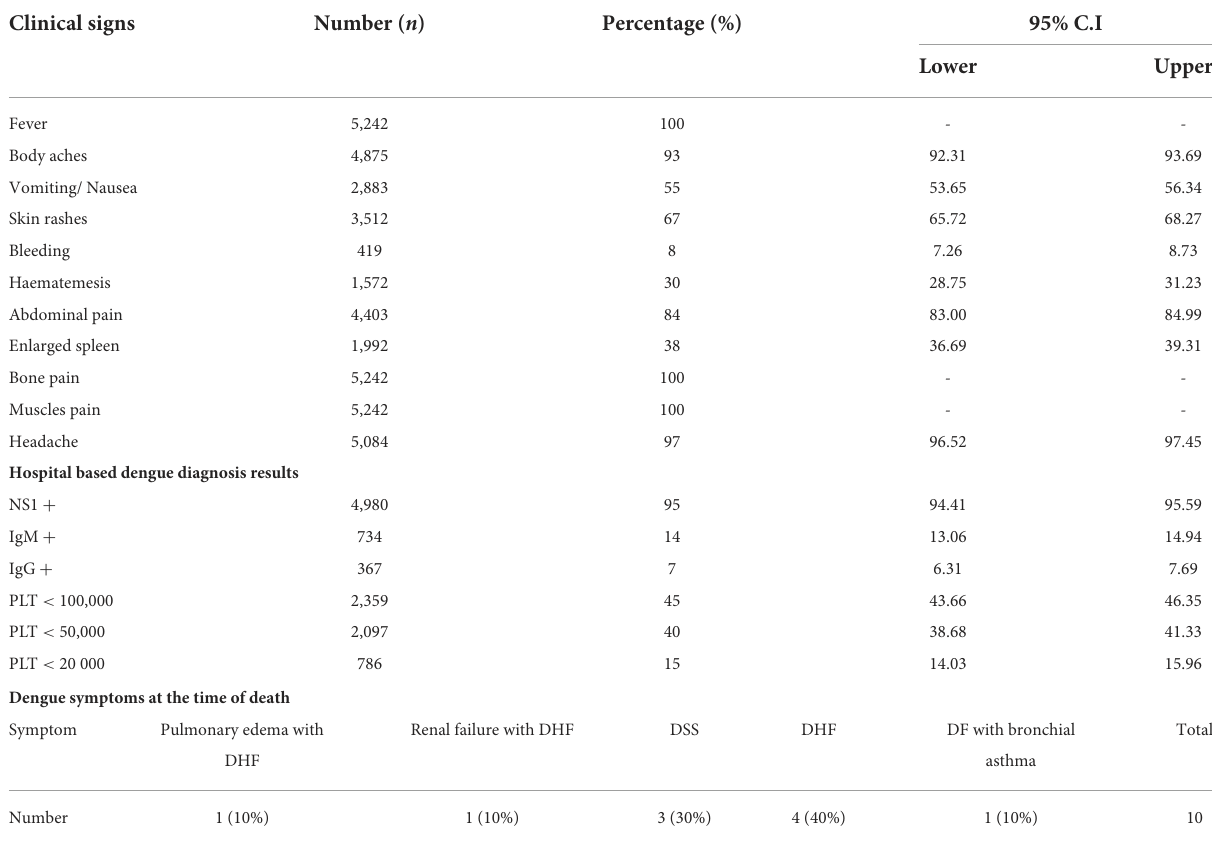
TABLE 1 Clinical characteristics of dengue fever during